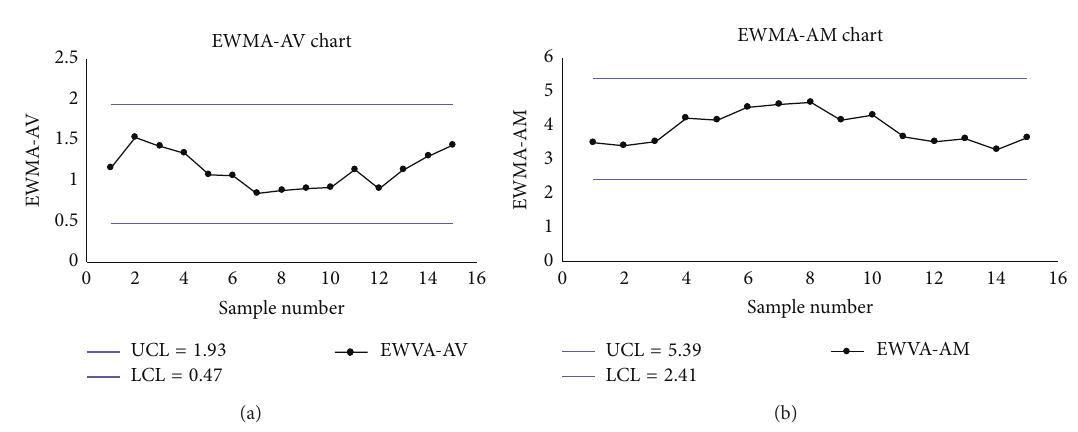
Figure 8: (a) The EWMA 𝑆 chart. (b) The EWMA 𝑋 chart.